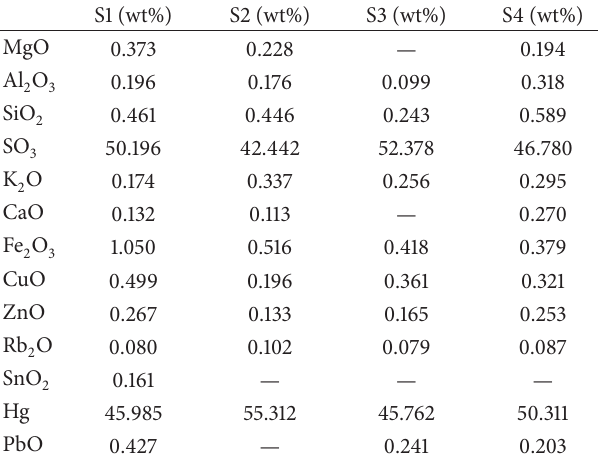
Table 2: Element concentrations in Zuota samples. The data were obtained from XRF and expressed as percentage of